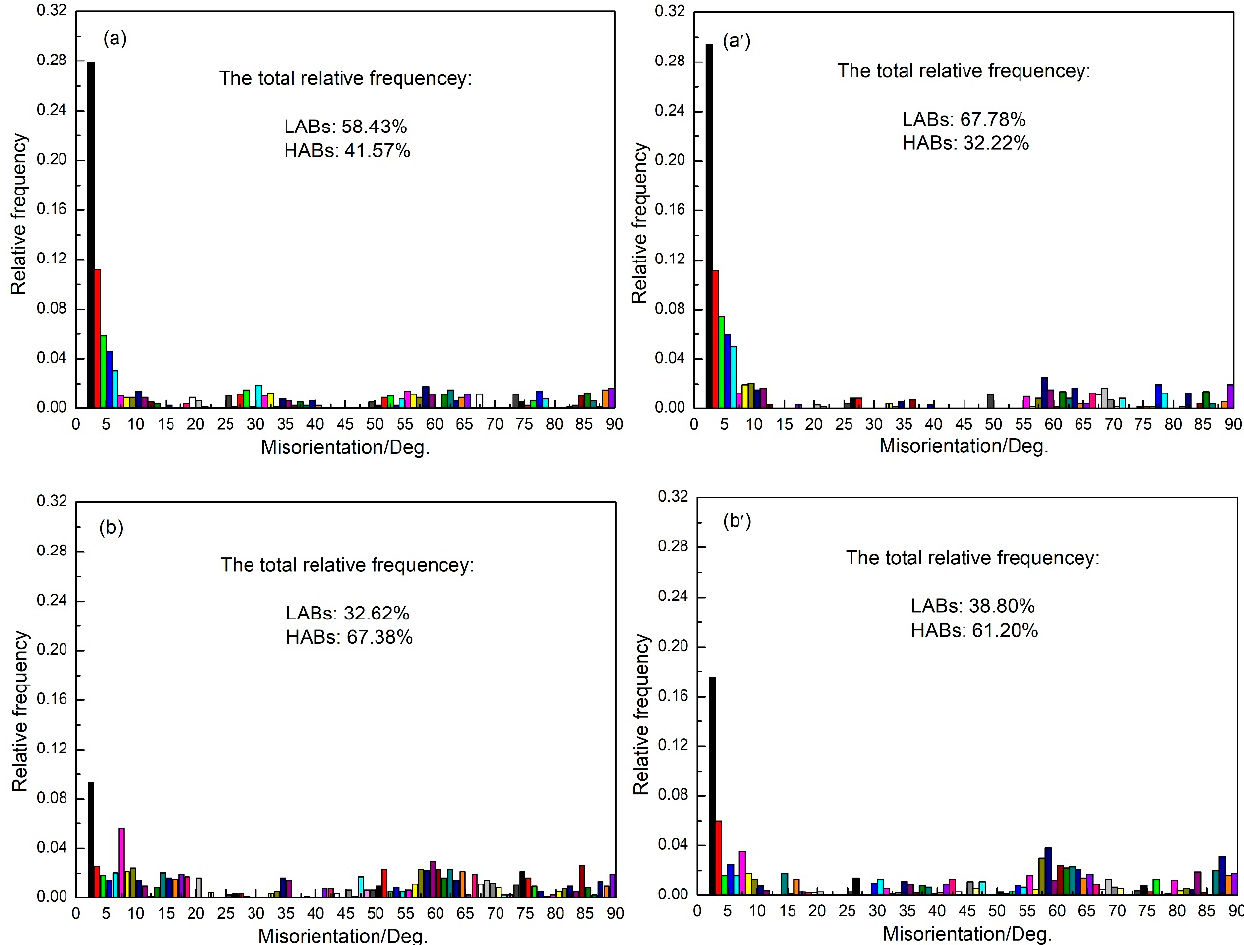
Figure 9. Misorientation distribution of the α grain boundary in BZ ( left figures ) and VBZ ( right figures ) at different times: ( a , a ′ ) 1 min; ( b , b ′ ) 10 min.